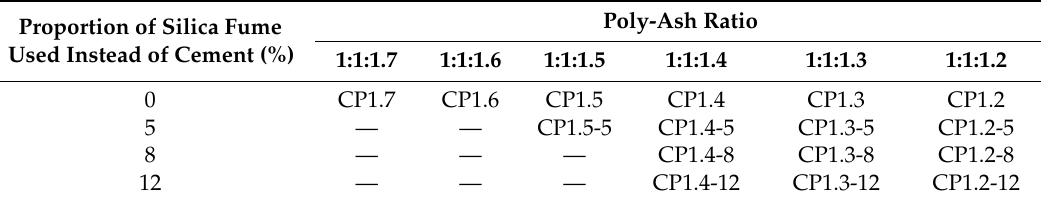
Table 4. Test block